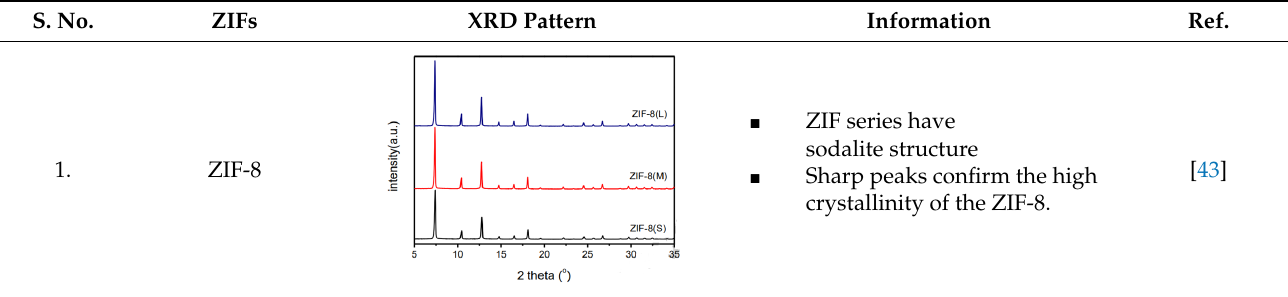
Table 4. ZIFs and their observations after XRD.